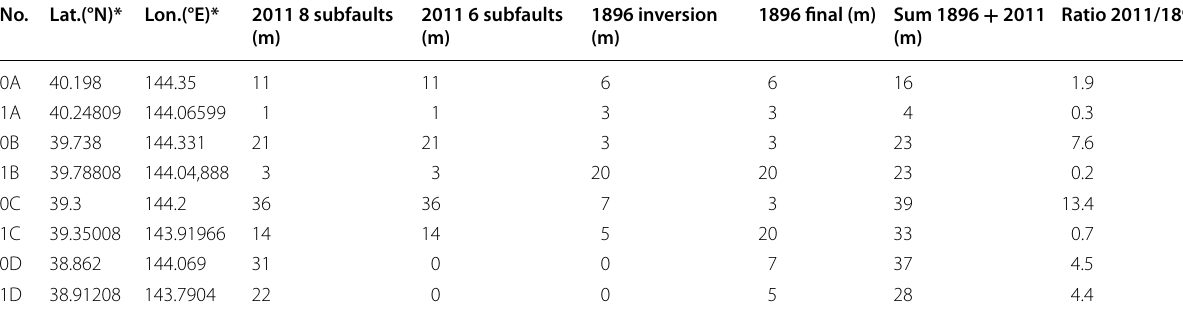
* Location (latitude [Lat.] and longitude [Lon.]) indicates the northeast corner of each subfault. The fault length: 50 km, the fault width: 25 km, the strike: 193°, the dip angle: 8°, and the slip angle: 81° are common to all the subfaults. The top depths are 0 km and 3.5 km beneath seafloor, for subfaults 0* and 1*, respectively